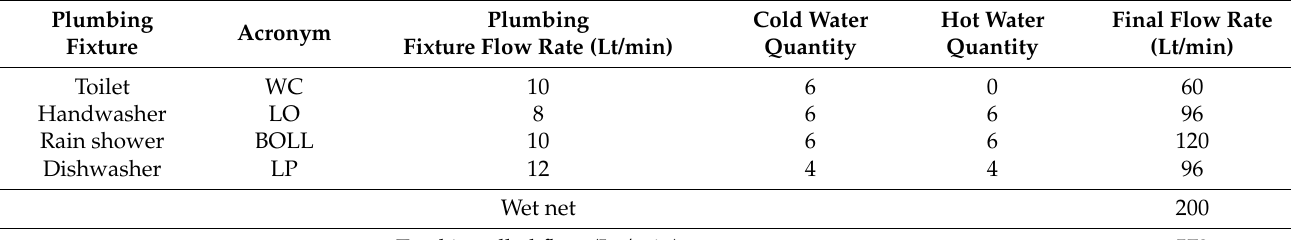
Table 12. Total installed loads chart for a commercial building.